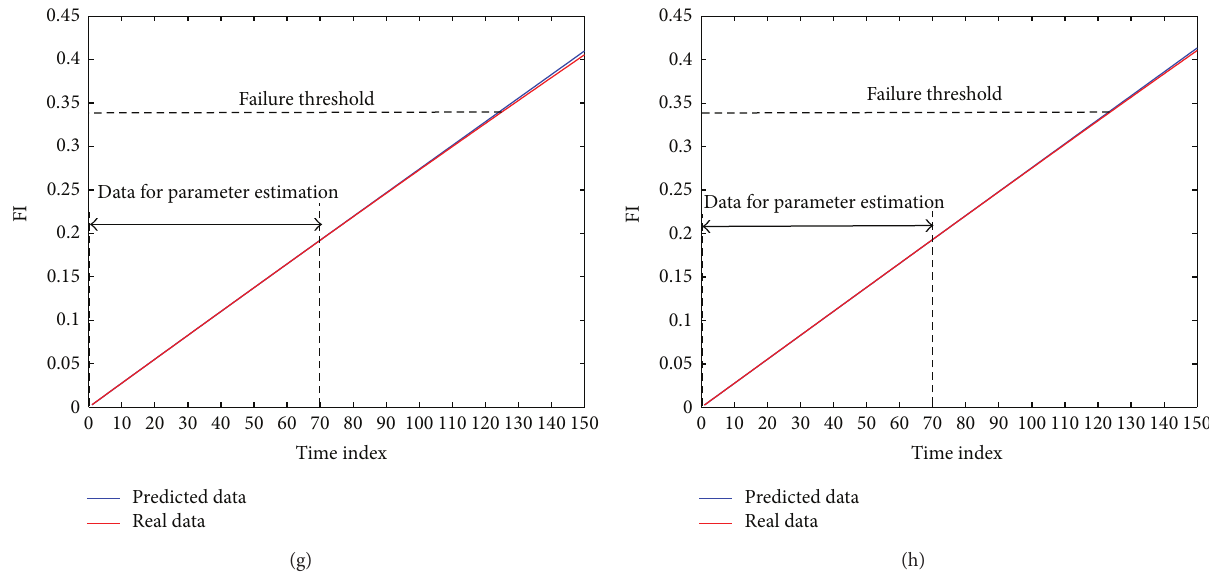
Figure 12: (a) The result obtained when 70 time index data are used to predict 50% of 𝑅1 deviation in a forward direction. (b) The result obtained when 90 time index data are used to predict 50% of 𝑅1 deviation in a forward direction. (c) The result obtained when 70 time index data are used to predict 50% of 𝑅1 deviation in a negative direction. (d) The result obtained when 90 time index data are used to predict 50% of 𝑅1 deviation in a negative direction. (e) The result obtained when 70 time index data are used to predict 50% of 𝐶2 deviation in a forward direction. (f) The result obtained when 70 time index data are used to predict 50% of 𝐶2 deviation in a negative direction. (g) The result obtained when 70 time index data are used to predict 50% of 𝑅6 deviation in a forward direction. (h) The result obtained when 70 time index data are used to predict 50% of 𝑅6 deviation in a negative direction. Table 2: Effect of simulation and prediction on single components. Degradation